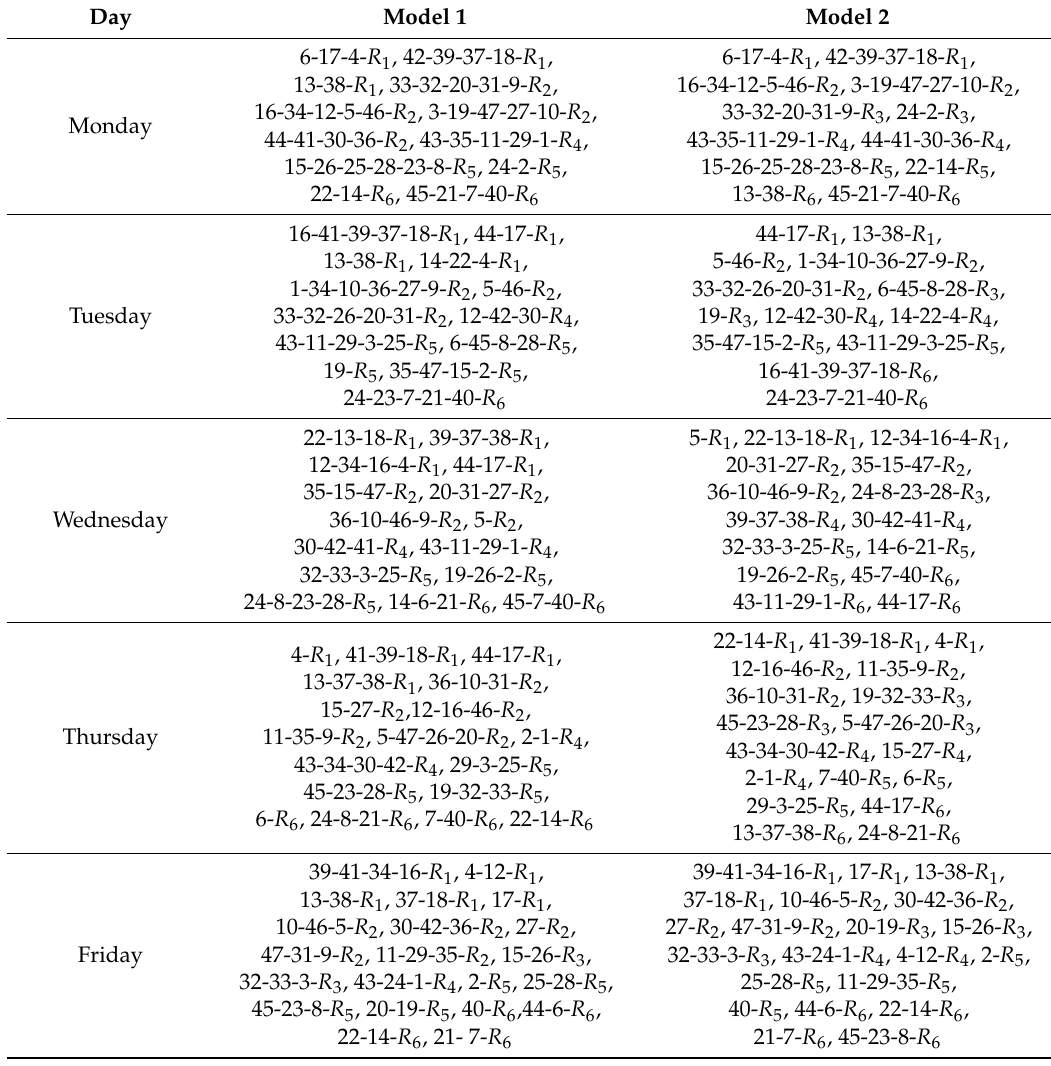
Table A2. Detailed collection routes of model 1 and model 2 from Monday to